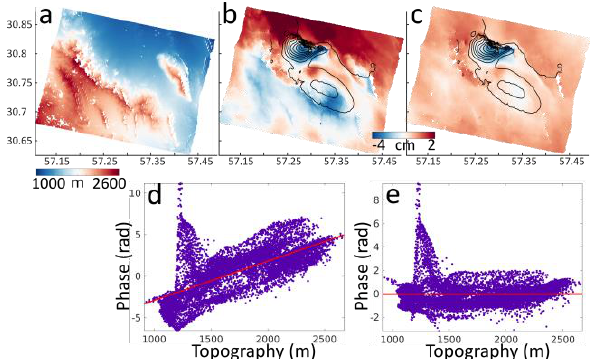
Figure 4. a: Topographic map. b: Cumulative displacement map as a result of time series analysis performed on the original dataset. c: Cumulative displacement map applied to the reconstructed interferograms obtained from ICA based analysis. The black isocontours are superimposed on the cumulative deformation maps that represent coseismic signal resolved from two events of 1 and 12 December 2017. d,e: Scatter plots showing strong and week correlation between topography and cumulative displacements represented in (b) and (c),